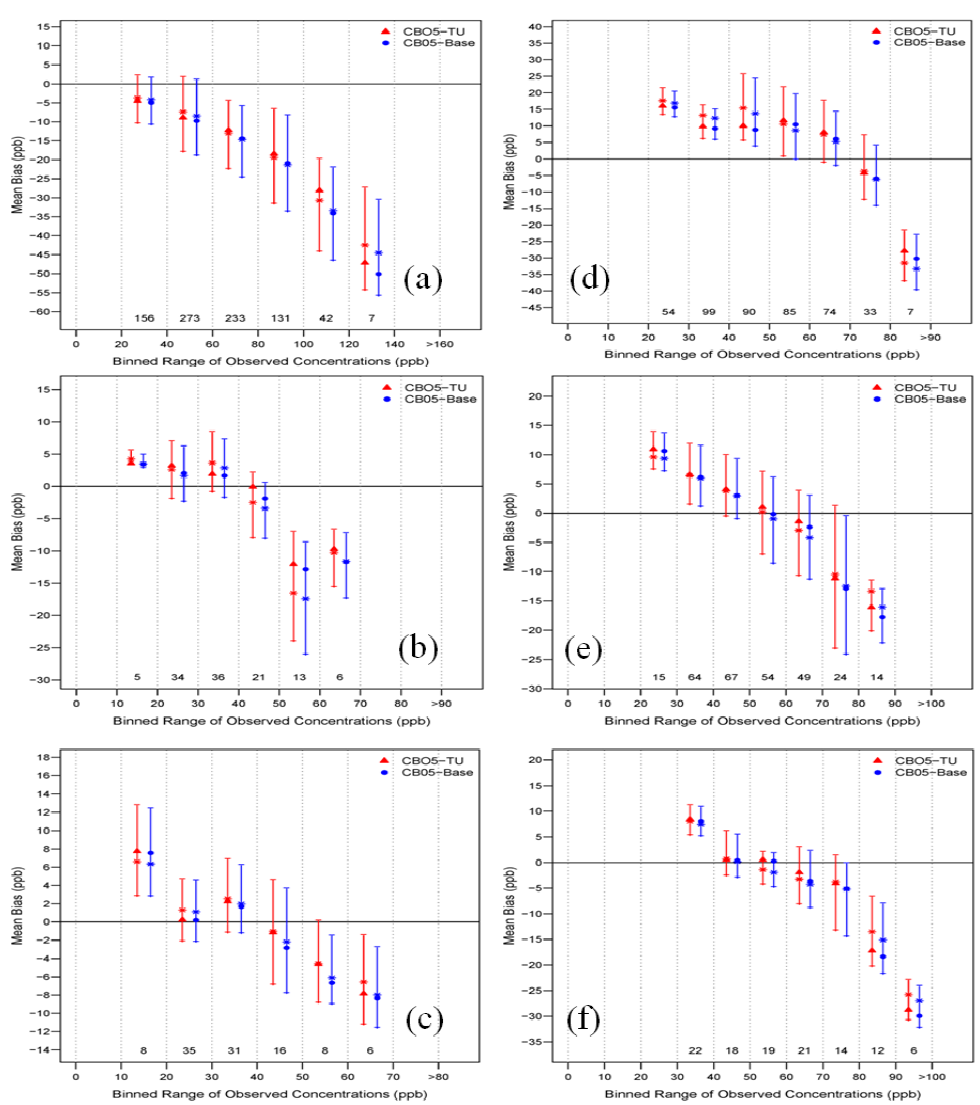
Figure 7: The median and inter-quartile range of mean bias for the daily maximum 8-hr O CB05-TU and CB05-Base: (a) Los Angeles (b) Portland (c) Seattle (d) Chicago (e) New York/New Jersey (f) Detroit. Number beneath each paired evaluation represents the total sample number in each binned range of observed concentration.